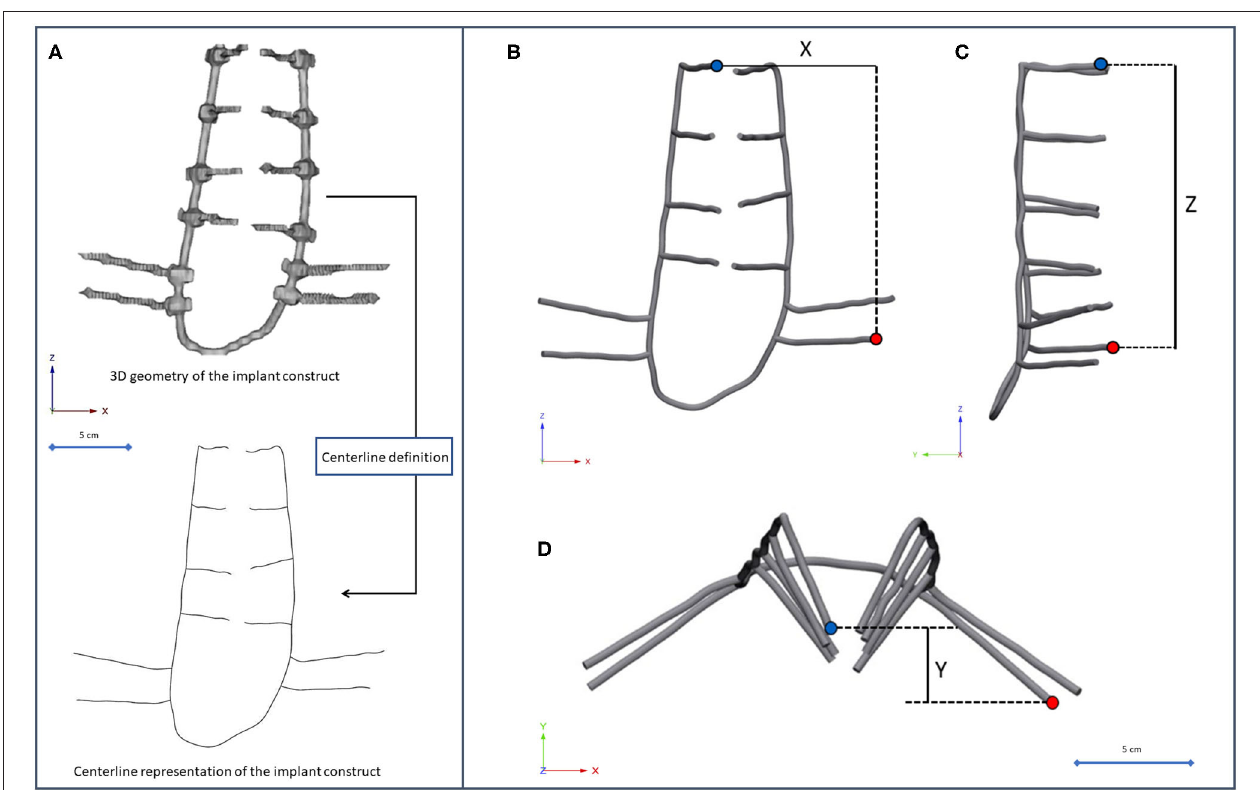
FIGURE 4 | Implant construct geometry simplification and deformation measurement. (A) The segmented geometry of the implant construct was considered a tubular structure, the centreline of the geometry was defined. (B–D) A fixed point (red dot) was selected in the centreline corresponding to the tip of the caudal trans iliac screw, and a mobile point (blue dot) corresponding to the L2 right pedicle screw tip. The distance between the points was determined (B) in the coronal plane (X d ), (C) sagittal plane (Z d ), (D) axial plane (Y d